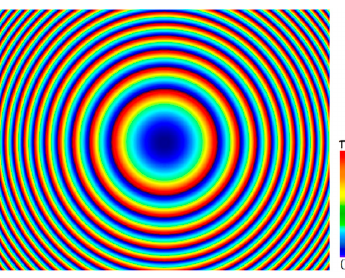
Figure 1. The simulated director distribution of the Pancharatnam–Berry phase lens.